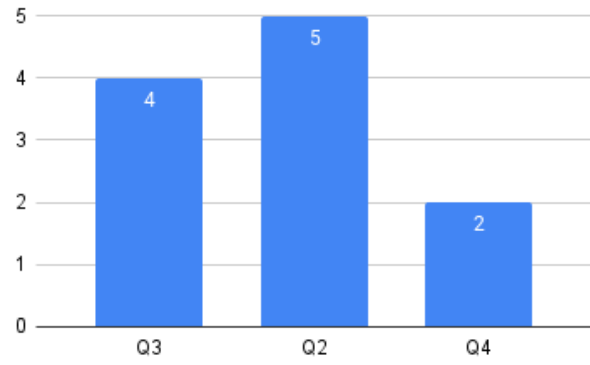
Figure 17. Journals according to their JCR quartil indexation.